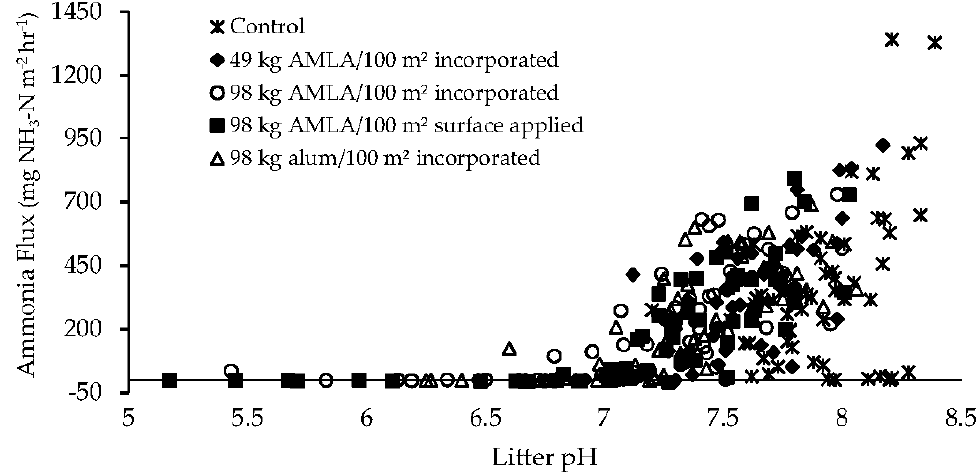
− 2 hr − 1 ) as a function of litter